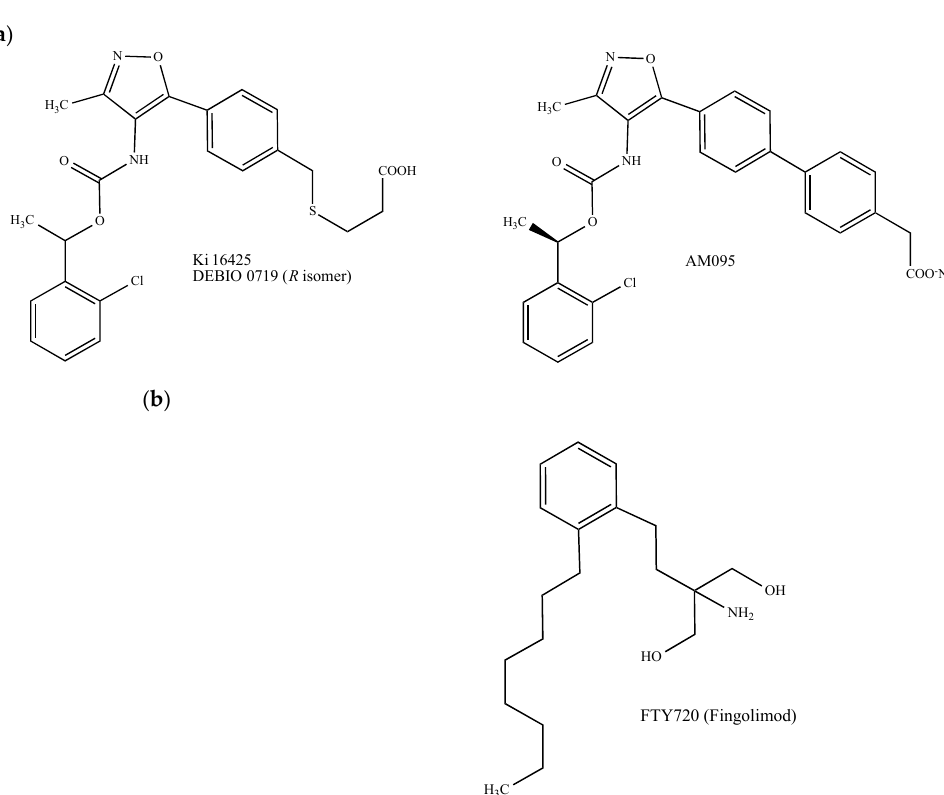
Figure 2. Structure of ( a ) lysophosphatidic acid (LPA) and ( b ) sphingosine-1-phosphate (S1P) antagonists.